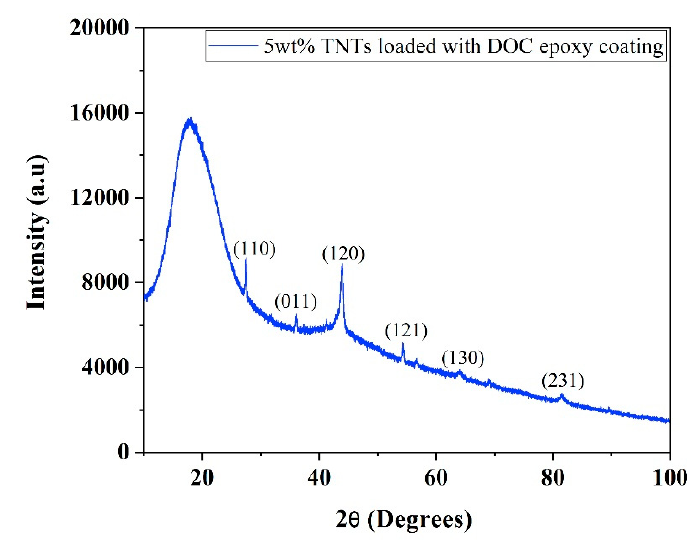
Figure 3. XRD pattern of as-synthesized nanocomposite epoxy coatings.